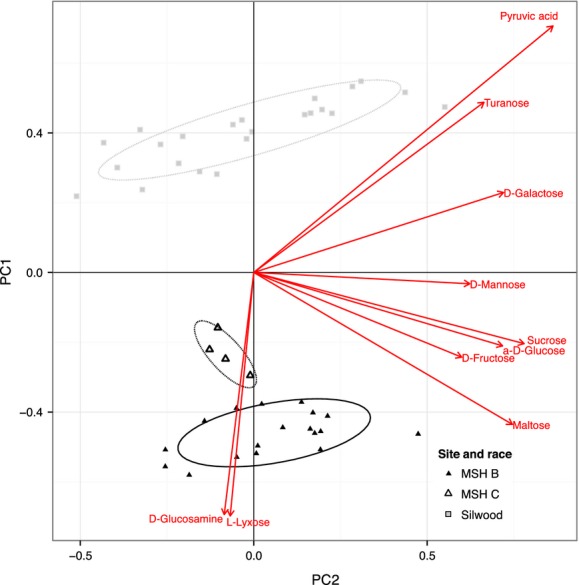
The divergence of yield among isolates summarized by projection on the two dominant principle component axes. Mean value for each isolate is presented. MSH isolates are shown as triangles, race B as solid triangles, and race C as hollow triangles, and Silwood isolates by gray squares. Ellipses show 95% confidence intervals. The ordination of the ten substrates that contribute most to PC1 are shown as red lines.